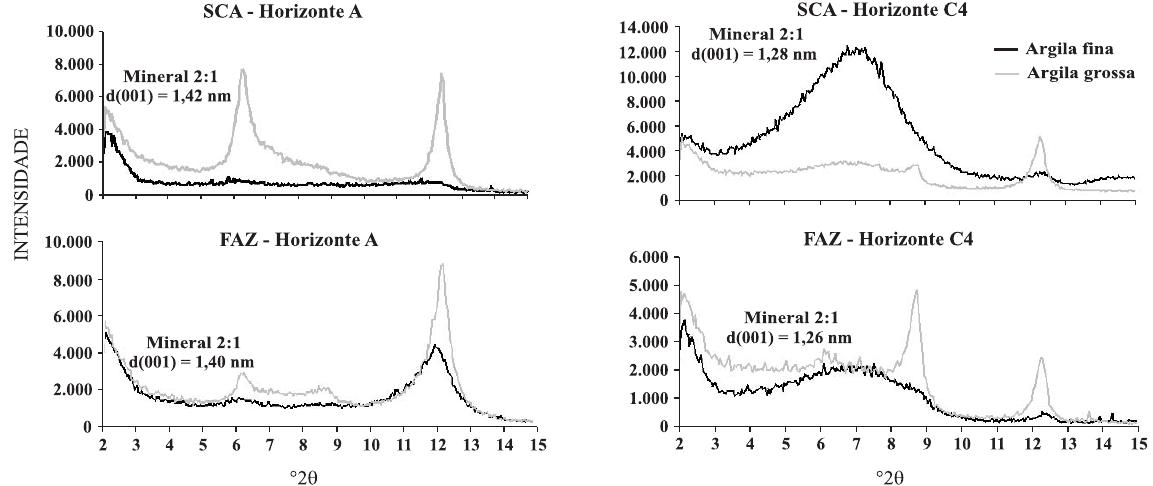
Figura 3. Difratogramas de raios X de amostras desferrificadas e orientadas de argila fina e grossa dos horizontes A e C4 do perfil do Setor de Ciências Agrárias (SCA) e da Fazenda Experimental do Canguiri (FAZ) da